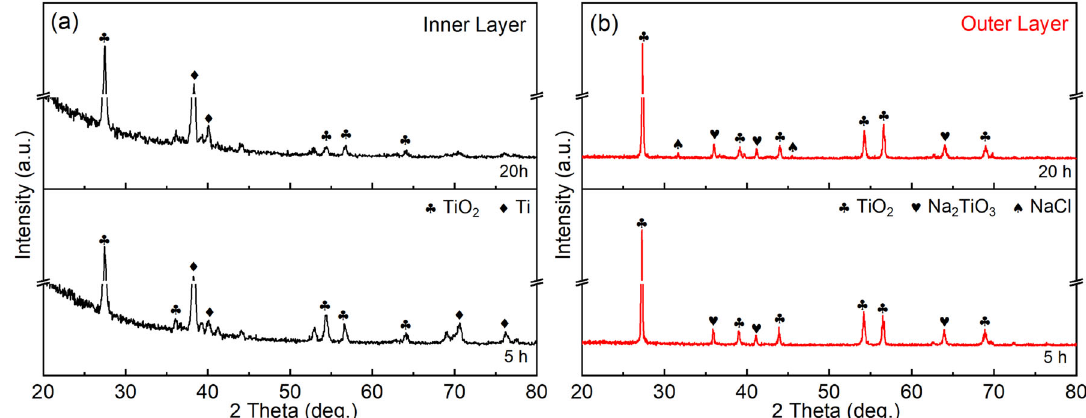
Fig. 2 XRD patterns of the corrosion products of the Ti after corrosion with continuous NaCl solution spraying for 5 h and 20 h at 600 °C. a the corrosion products of the inner layer, and b the corrosion products of the outer layer. npj Materials Degradation (2022)